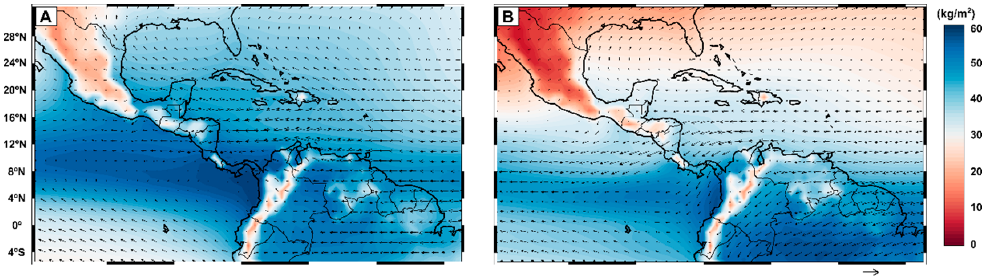
Figure 3. Mean total column water vapour (shaded) and the vertically integrated water vapour flux (arrows) for ( A ) May–October and ( B ) November–April for the 1979–2019 period based on ERA–5 data. A high moisture content was observed between May and October with transport mostly directed along the storm track, following the development of the meridional branch of the CLLJ. In contrast, a reduced moisture content is featured in the November–April period. Here, transport is directed across Central America, with the cross–isthmus transport characteristics of a drier season.